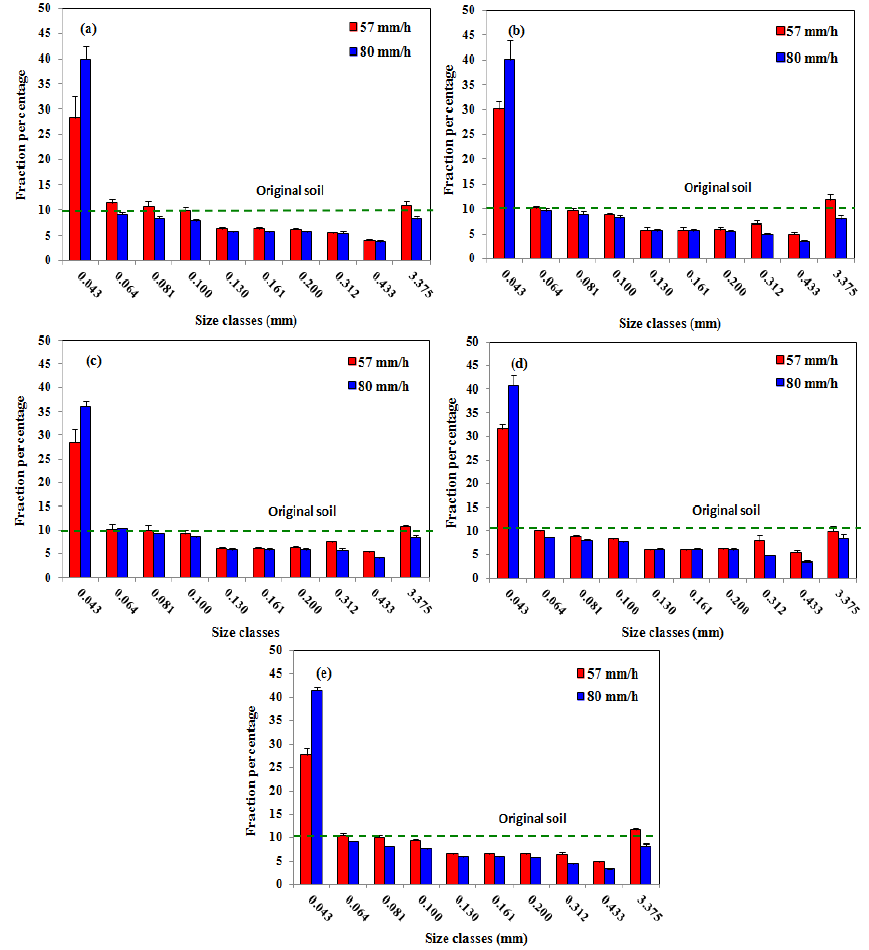
Figure 4. Comparison of particle size distribution in eroded soil D max 4.75mm compared to the original soil and for different slopes of (a) 0.5, (b) 2.5, (c) 5, (d) 10 and (e) 20%. Error bars represent standard errors of the